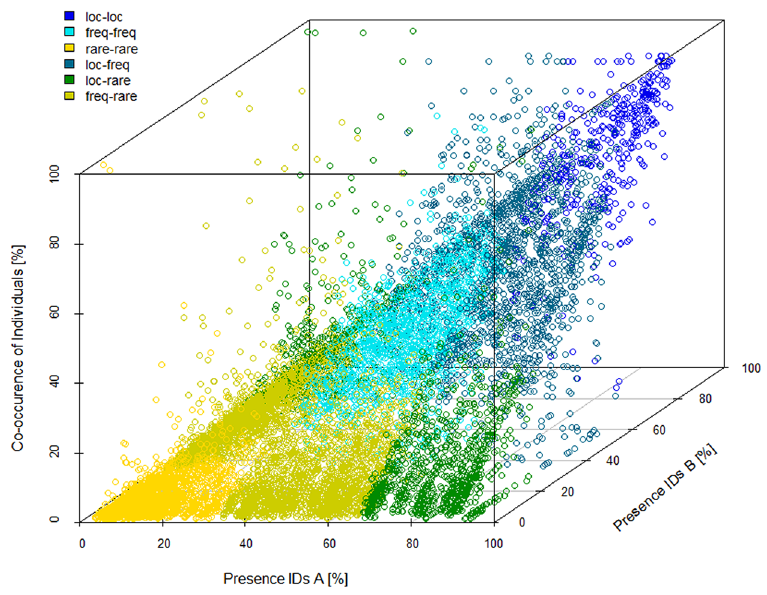
Figure 1. Co-occurrence of every combination of two individuals (A + B) at a single food source (Austrian study site). The percentage of days each raven was present is always shown for one individual of each combination on the x-axis (IDs A) and for the other one on the y-axis (IDs B). The z-axis represents the percentage of co-occurrence of these individuals. The different colors show the combinations of classified presence patterns: locals (loc), frequent visitors (freq) and rare visitors (rare). Only ravens that were present at least 10 times are included (N =